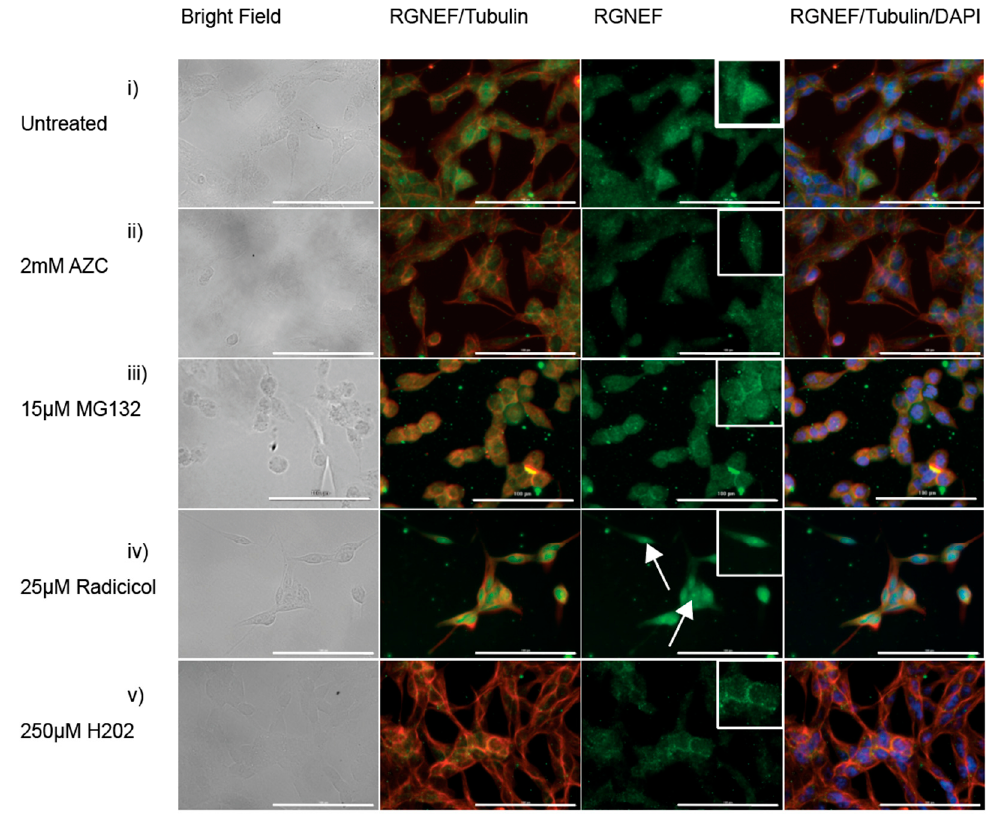
Figure 6. RGNEF localization under cellular stress in Neuro-2a cells. Endogenous RGNEF is visualized by immuno-fluorescence microscopy in untreated and stress treated conditions in semi-differentiated Neuro-2a cells, ( i ) untreated, ( ii ) 2 mM AZC, ( iii ) 15 μ M MG132, ( iv ) 25 μ M radicicol (white arrows indicate nuclear RGNEF inclusions), and ( v ) 250 μ M hydrogen peroxide. (40× magnification, scale bar = 100 μ m).